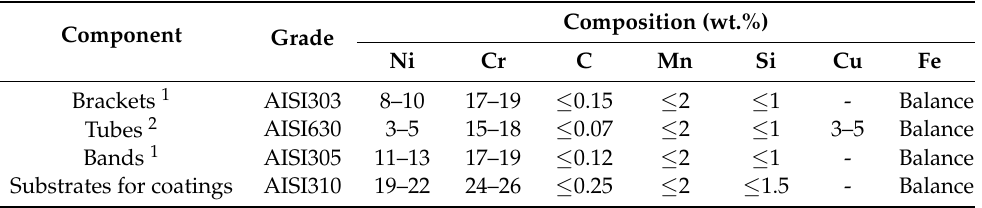
Figure 1. Representative orthodontic components used in this study: ( a ) brackets, ( b ) tubes, and ( c ) band (with attached tube). The resin-covered bases of a bracket and a tube are highlighted (*). Table 1. Nominal chemical composition of the commercially available SS components of fixed orthodontic appliances and AISI310 substrates.